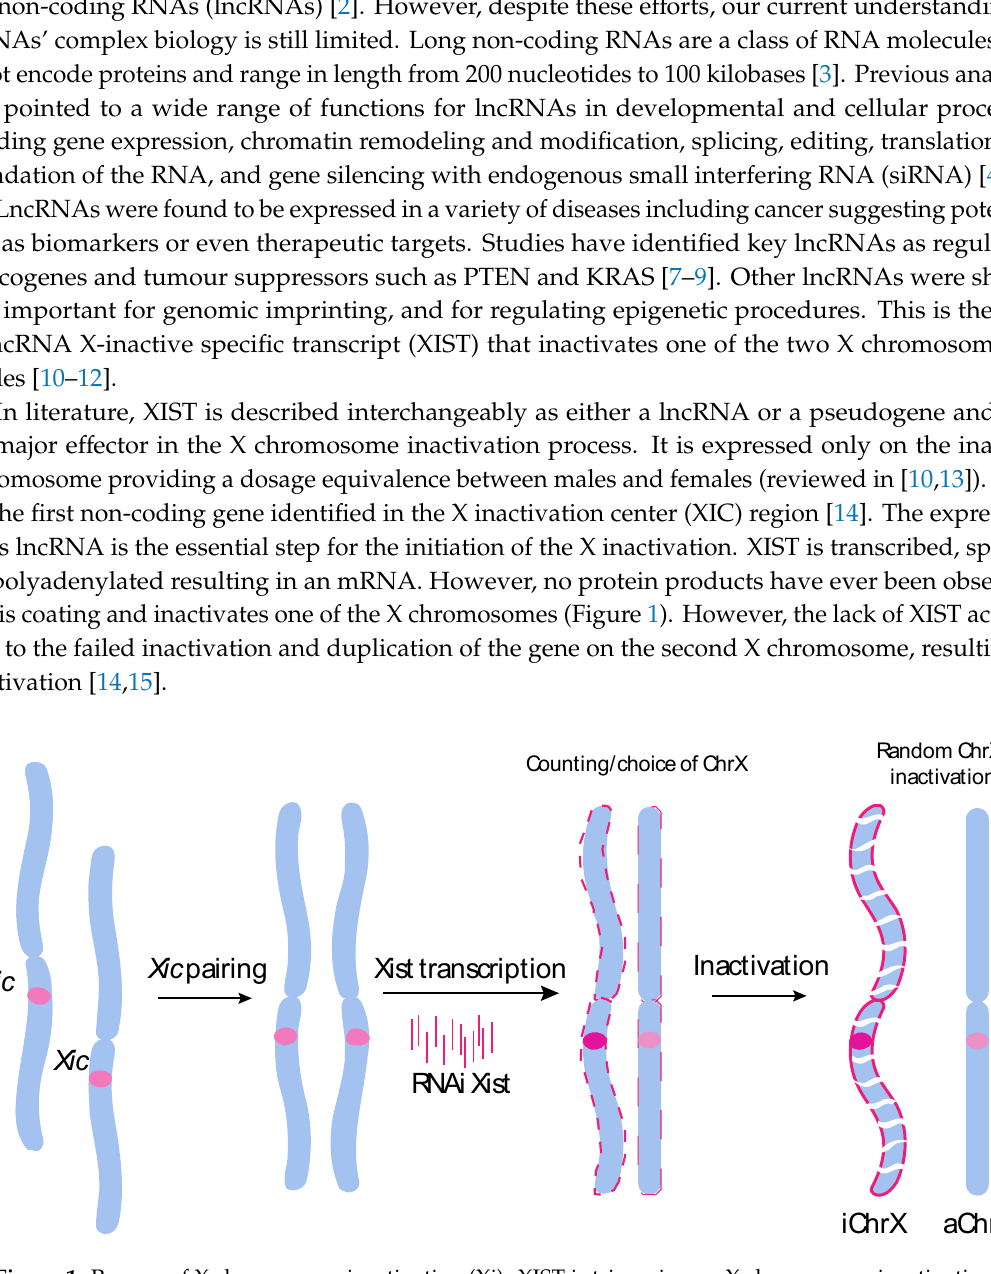
Figure 1. Process of X chromosome inactivation (Xi). XIST is triggering an X chromosome inactivation while the other X chromosome remains active. XIST is spreading along one of the X chromosomes (coating) and its binding triggers the chromatin inactivation. Xic: X-inactivation center, iChrX: inactive Xchr, aChrX: active Xchr [14].